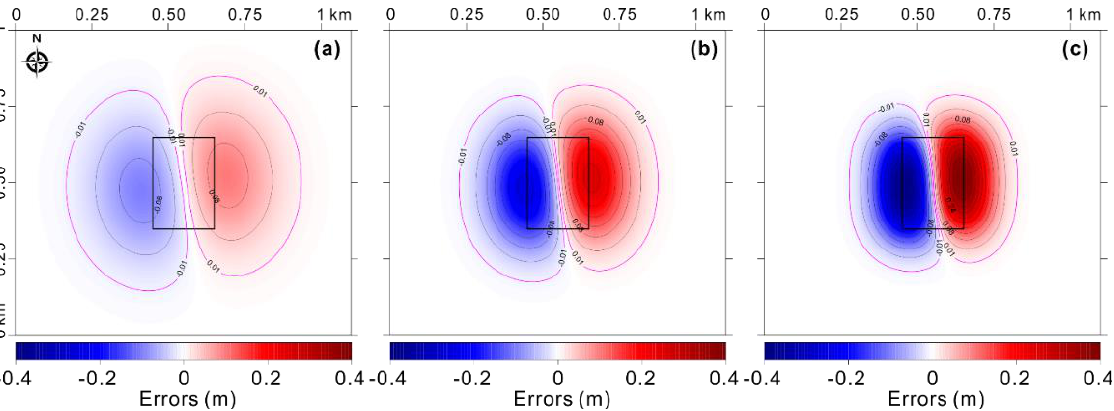
Table 1. The common ranges of the subsidence factor ( q ) and tangent of major influence angle (tan β ) for the hard, medium, and soft overlying rock strata.